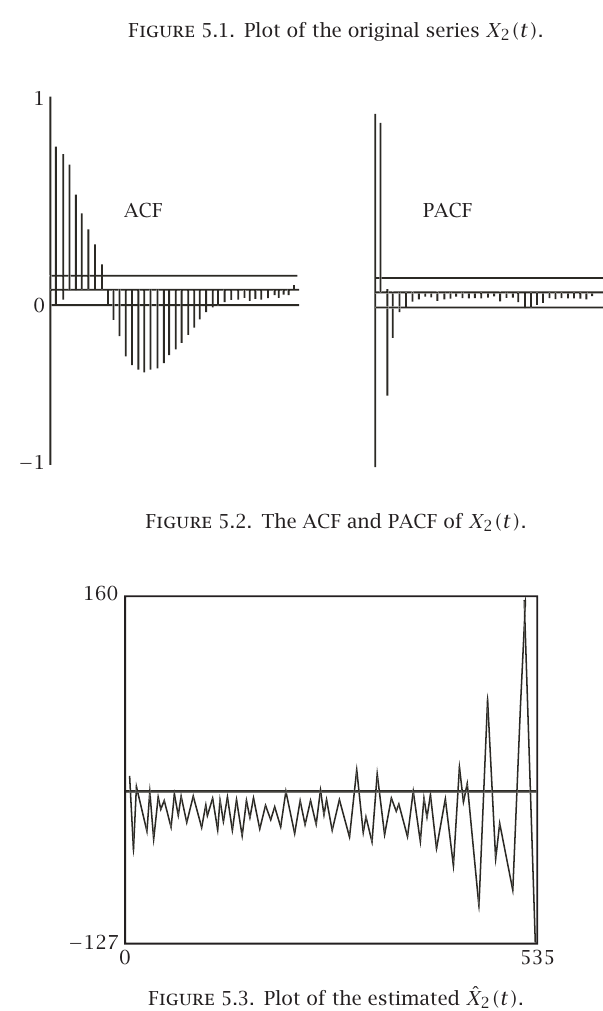
Figure 5.3 . Plot of the estimated ˆ X